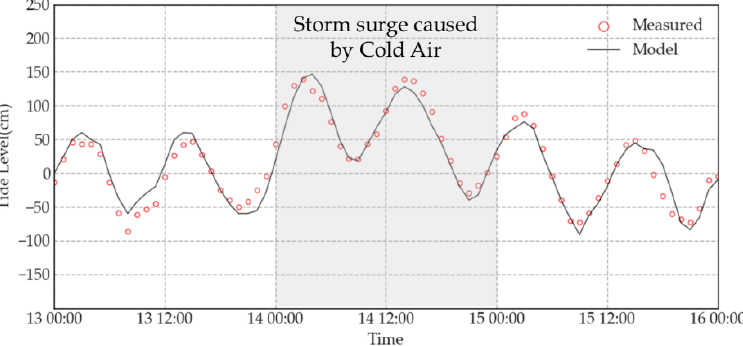
Figure 5. Comparison of measured and modeled tide levels during storm surges.